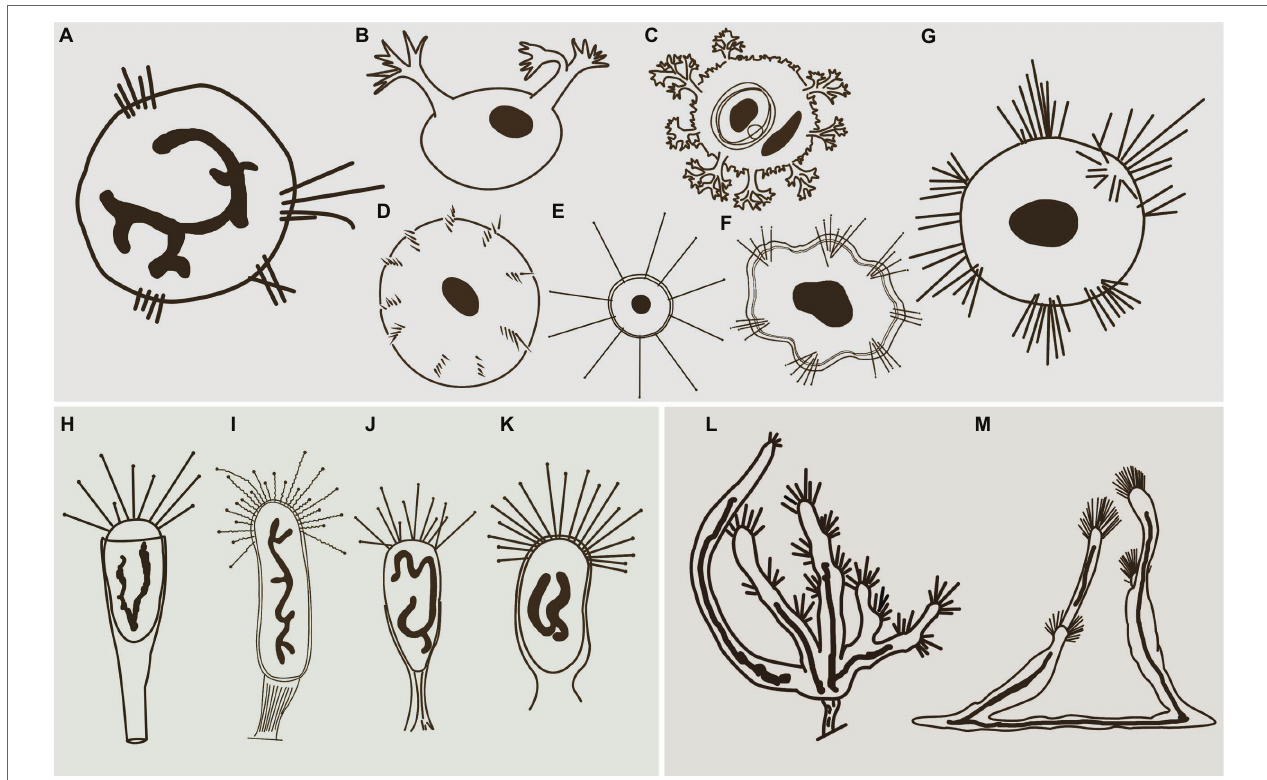
FIGURE 10 | Some selected species that are morphologically similar to four species in this study. (A) Cyclophrya magna Gönnert, 1935 (after Dovgal, 2002). (B) Dendrocometes paradoxus Stein, 1851 (after Dovgal, 2002). (C) Niscometes peregrinus Small & Lynn, 1958 (after Dovgal, 2002). (D) Discosomatella tenella Swarczewsky, 1928 (after Dovgal, 2002). (E) Heliophrya minima (Rieder, 1936) Foissner, 1988 (after Foissner et al., 1995). (F) Heliophrya sinuosa Rieder, 1936 (after Rieder, 1936). (G) Heliophrya rotunda (Hentschel, 1916) Matthes, 1954 (after Dovgal, 2002). (H) Peridiscophrya florea (Kormos & Kormos, 1958) Dovgal, 2002 (after Zharikov et al., 2005). (I) Discophrya robusta , Nozawa, 1938 (after Nozawa, 1938). (J) P. crassipes (Rieder, 1936) Dovgal, 2002 (after Zharikov et al., 2005). (K) Peridiscophrya japonica Nozawa, 1938 (after Zharikov et al., 2005). (L) Dendrosomides paguri Collin, 1906 (after Dovgal, 2002). (M) D. radians Ehrenberg, 1838 (after Dovgal,